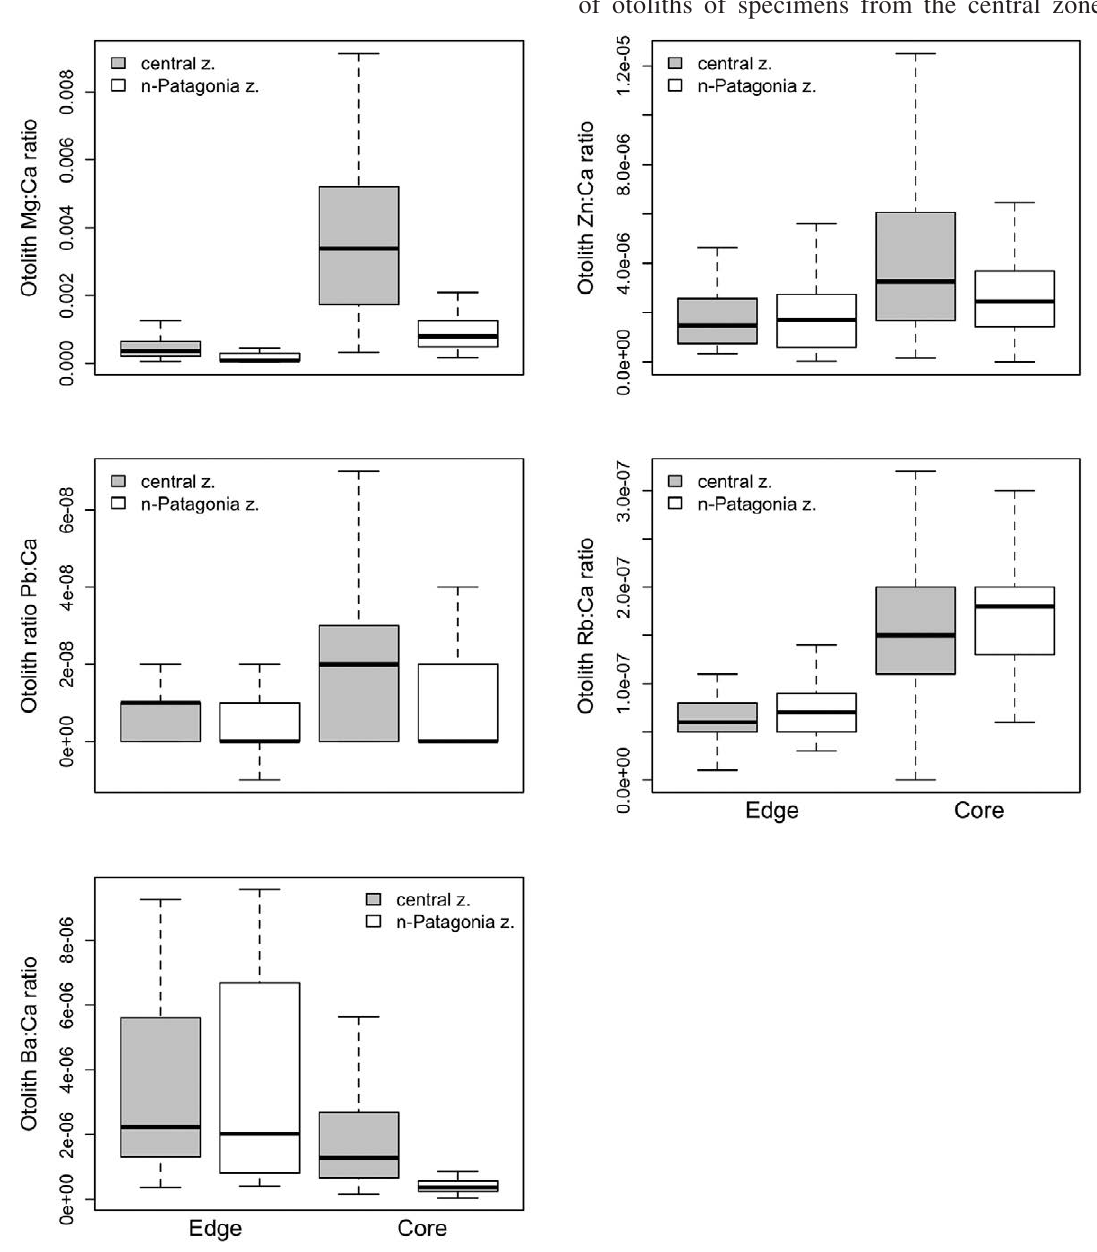
Fig. 5. – Box plot for Mg:Ca, Ba:Ca, Pb:Ca, Zn:Ca and Rb:Ca ratios for the edges and cores of the otoliths in the central zone and northern